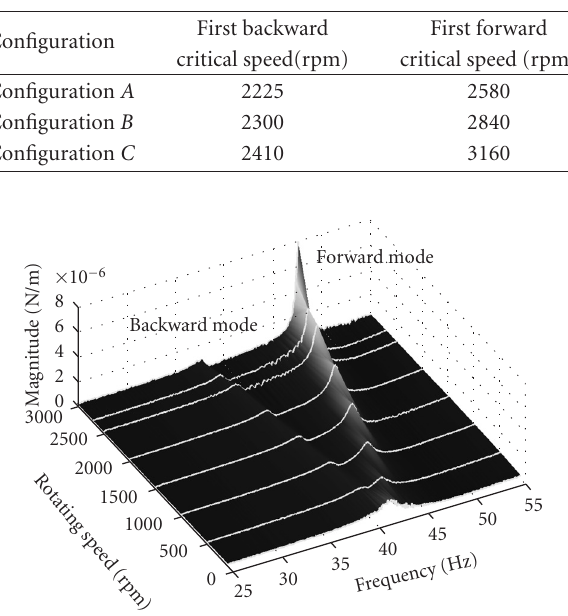
Figure 13: The waterfall function for the configuration B .